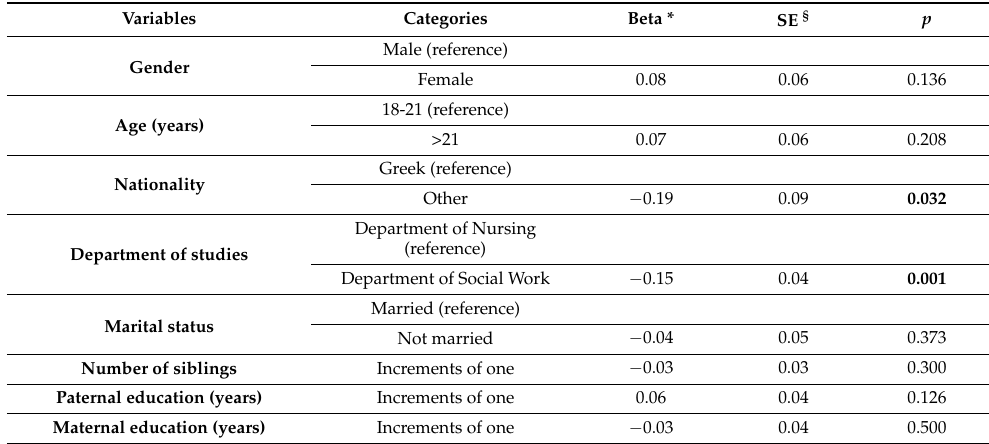
Table 6. Multivariate linear regression analysis of log-transformed knowledge scores about HPV vaccination, in association with sociodemographic features. Bold cells denote statistically significant